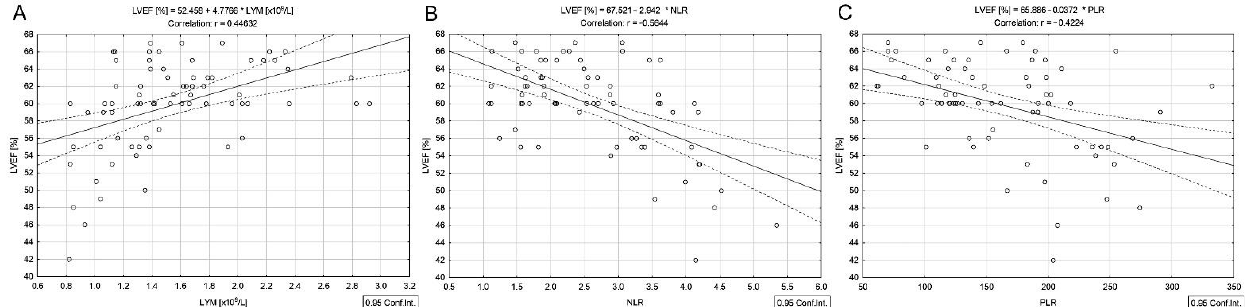
Figure 3. Correlations between LVEF and absolute lymphocyte count ( A ), NLR ( B ), and PLR ( C ) in differentiated thyroid cancer patients without type 2 diabetes mellitus.